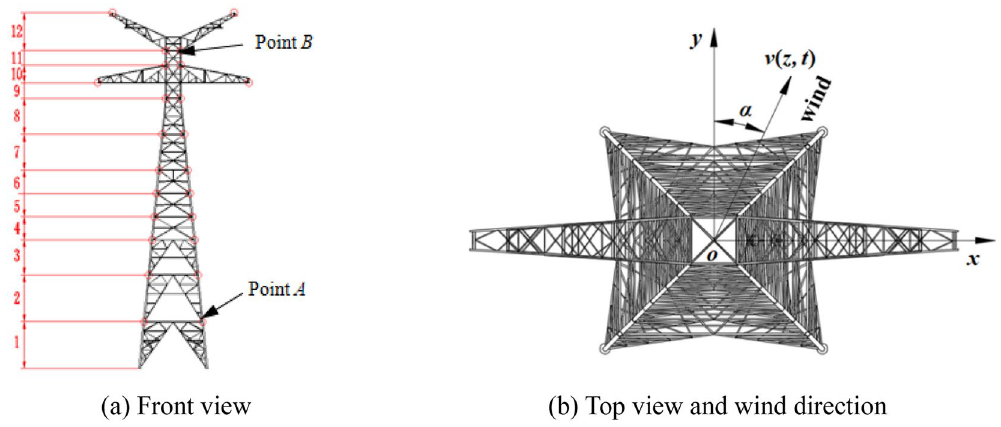
Figure 7. Sectional diagram of ISLSTT and wind pressure action